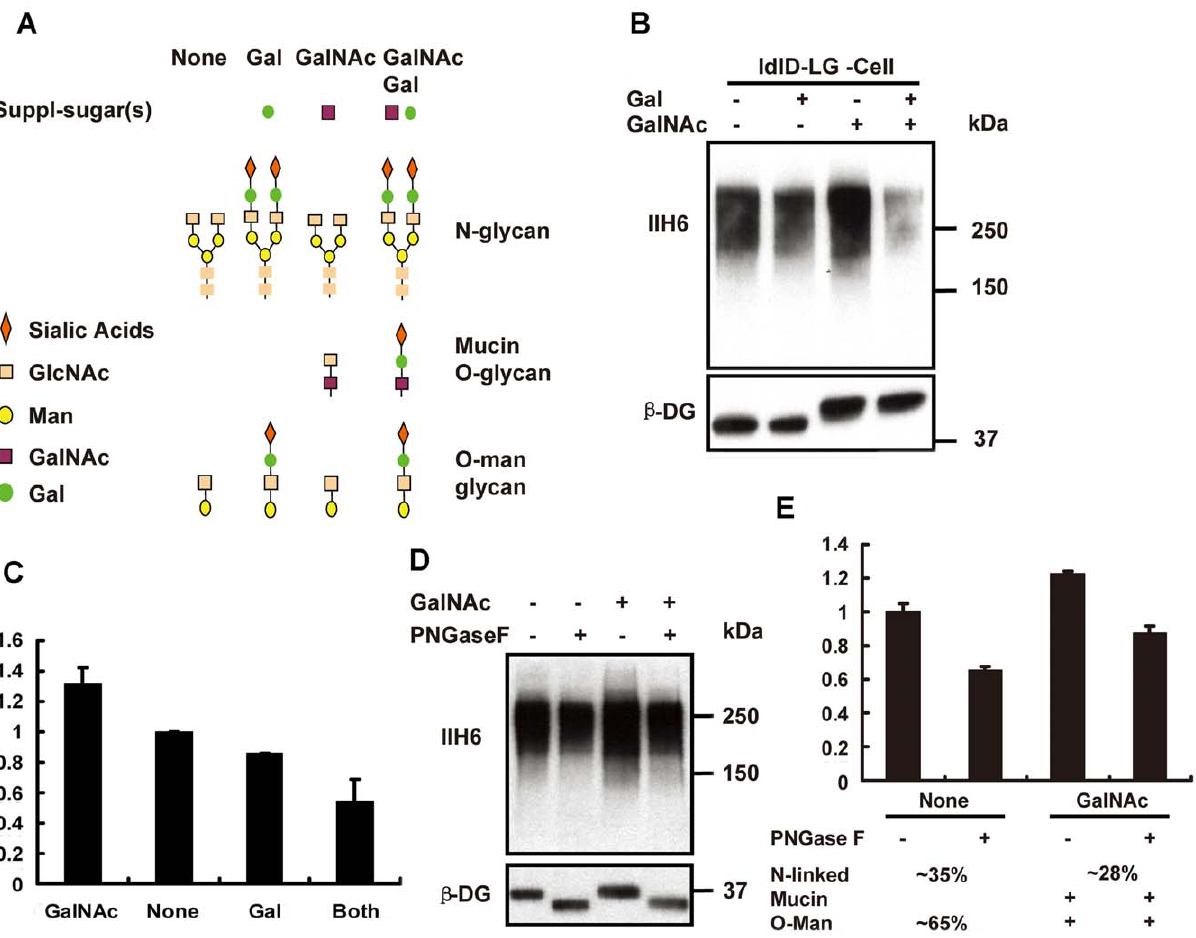
Figure 5. LARGE modifies both mucin type O-glycans and N-linked glycans on a -DG in ldlD cells while without galactosylation. (A) Predicted structures of the glycans in N-linked, Mucin and O-mannosyl pathway in the ldlD cells. (B)The ldlD-LG cells were maintained in F12 nutrition mix media with 3% lipoprotein deficient bovine serum for more than 48 hours prior to the experiment. The cells were seeded into 6-well plates one day before addition of indicated sugars (Gal at 10 m M and GalNAc at 200 m M). After being treated with the sugar(s) for 24 hour, the cell lysates were harvested and equal amount of the lysates were loaded. An immuno-blotting assay was performed to detect the functional glycans and b -DG with the IIH6 and b -DG antibody, respectively. (C) The quantitative data of the expression levels of the functional glycans were obtained with AlphaImage AIC software based on densitometers followed the manufacture instructions. The IIH6 expression levels were normalized with the expression levels of b -DG (N=3). (D) The lysates harvested from the ldlD-LG cells growing in the conditions as indicated and the experimental procedure is the same as described in (Fig. 4A). (E) Quantitative analysis of the data of (D) (N=3).